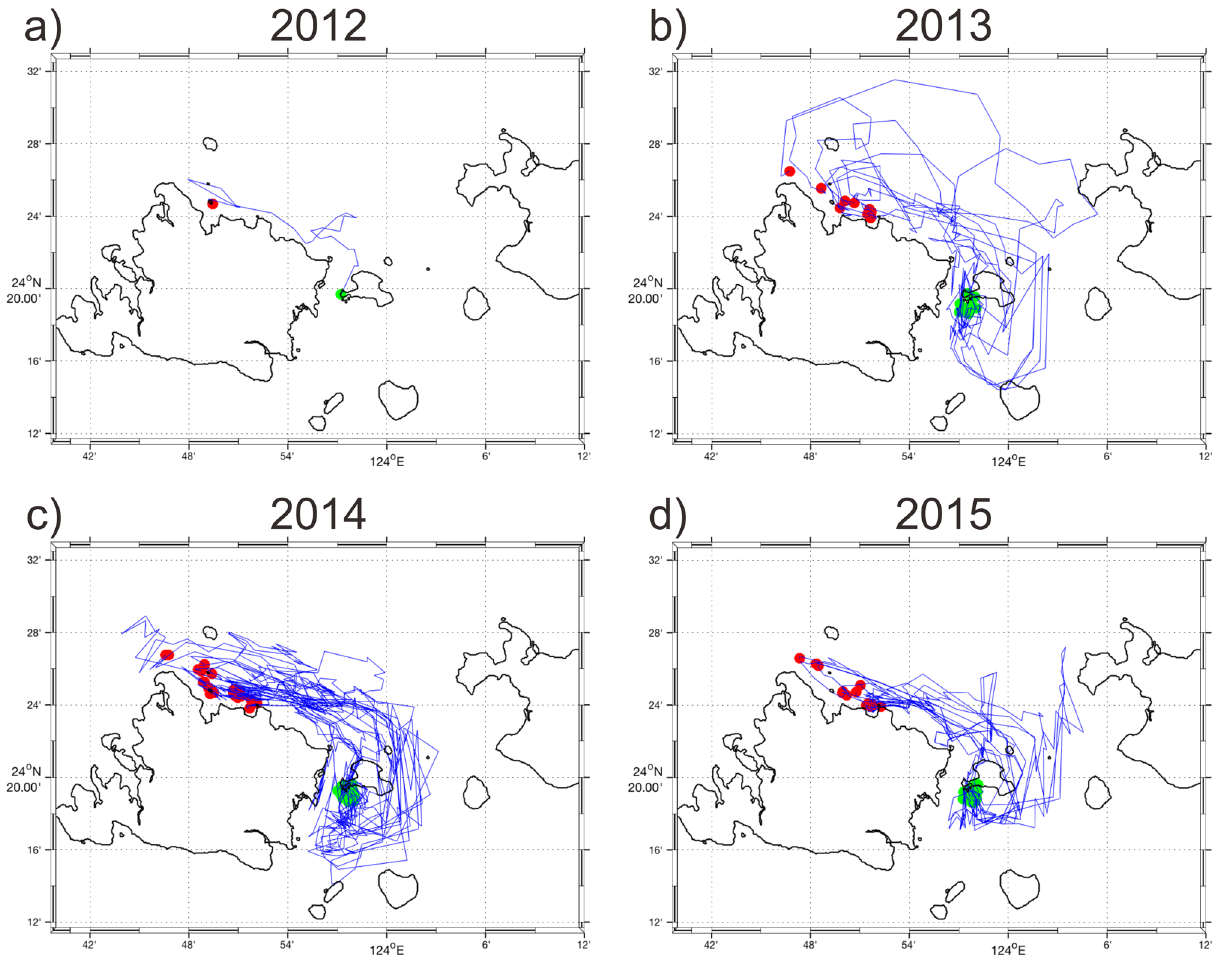
Figure 5. Trajectories of particles discharged from the northern coast of Iriomote Island (Group 1) that reached the southern coast of Kohama Island (Group 16) during the years 2012–2015 (a–d). Only 10% of the simulated trajectories are shown for clarity. Red and green dots indicate particle discharge and destination points in source and destination areas,